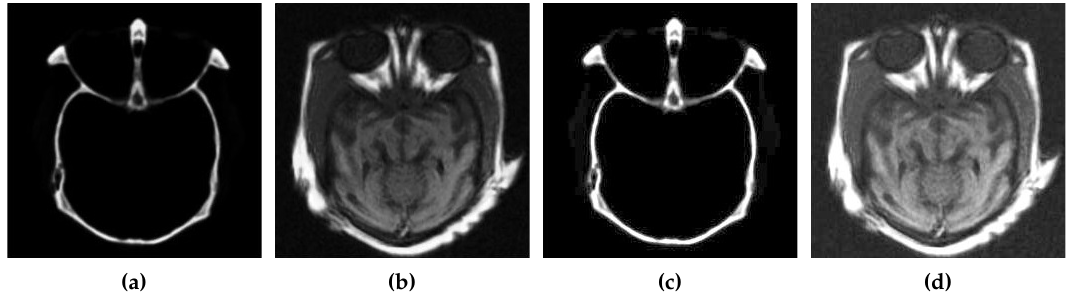
Figure 2. Contrast enhancement results, where ( a , b ) represent the source images and ( c , d ) show images with enhanced contrast using BIMEF.